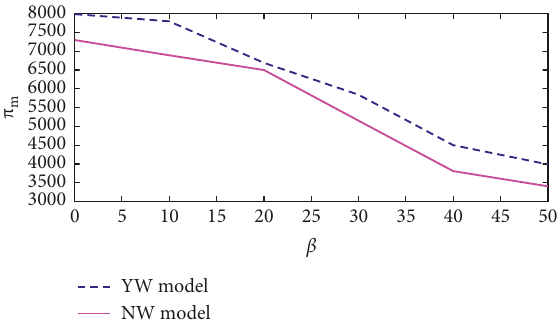
Figure 6: The impact of β on the manufacturer’s profit under the NW model and YW model.